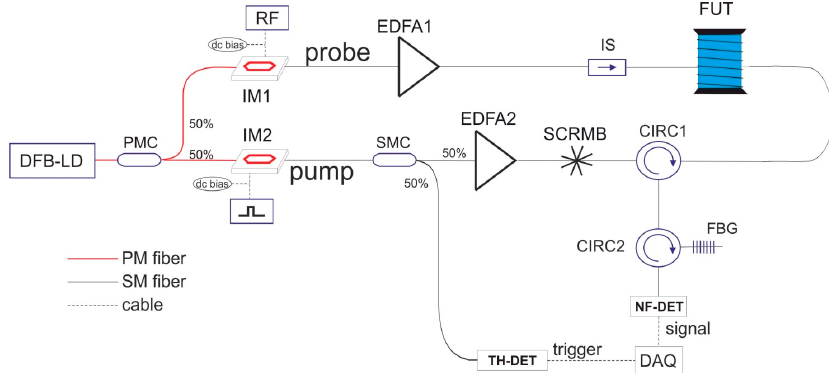
Figure 5. Schematic view of the Brillouin optical time domain analysis (BOTDA) setup. DFB-LD: